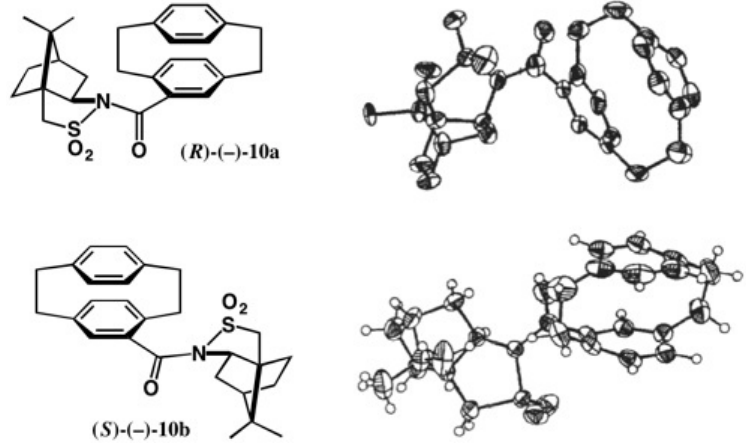
Figure 10. X-ray ORTEP drawings of camphorsultam amides ( R )-( − )- 10a and ( S )-( − )- 10b . Reprinted with permission from [23].